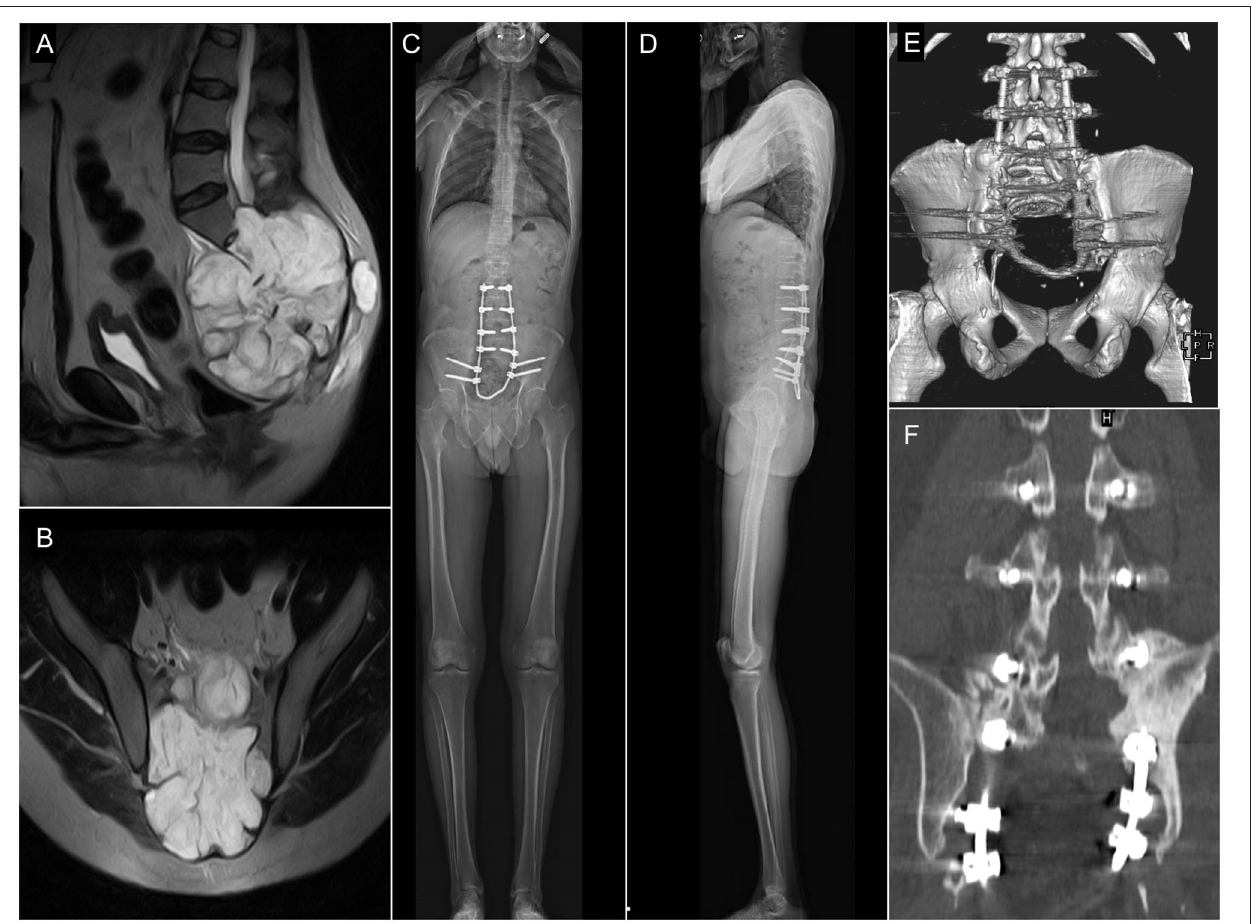
FIGURE 2 | Pre- and postop imaging of a 42 years old male patient who underwent total en-block sacrectomy and received a Closed-Loop spino-pelvic reconstruction. (A,B) Preop T2, MRI images of a large sacral chordoma [ (A) sagittal, (B) axial plane]. The extended tumor mass affected the whole sacrum with significant soft tissue extension to the retroperitoneum and cranially involving the paravertebral muscles. (C,D) Standing X-ray images of the patient at 6-month FU [ (C) sagittal, (D) coronal plane]. (E,F) CT scan at 24-month FU period. Signs of bony fusion are visible between the L4 and L5 vertebrae and the iliac bone [ (E) posterior view of the 3D rendered CT images; (F) coronal view at the fusion